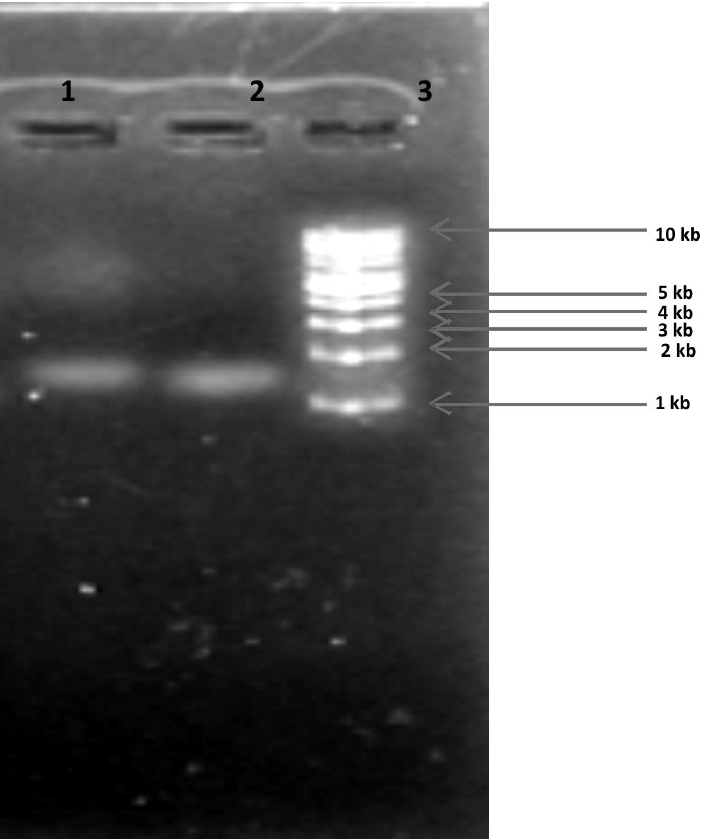
Figure 2. 16s rRNA gene amplification for bacterial isolates, where Lane 1 well was loaded with the Bacillus cereus sample, Lane 2 well was loaded with Bacillus haynesii sample, and as a check, a 10 Kb marker was loaded in Lane 3 well.